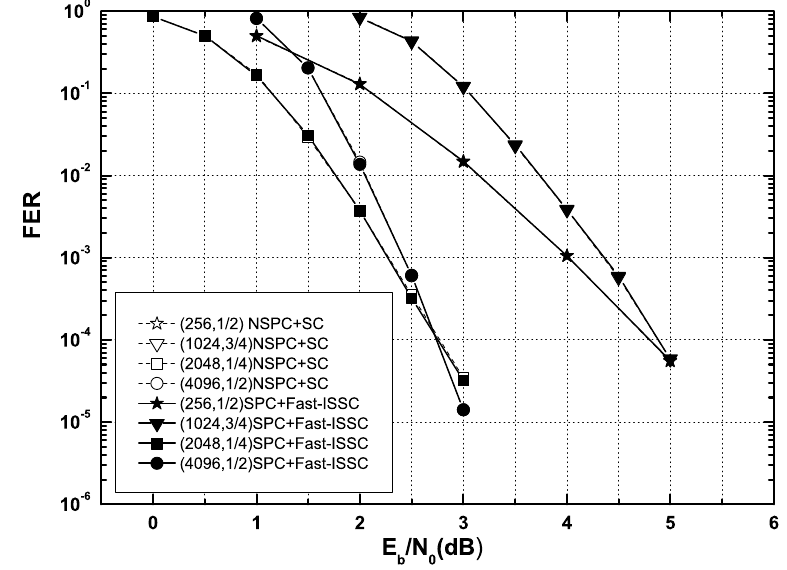
Figure 8. FERs of systematic polar codes under Fast-ISSC decoder and non-systematic polar codes under SC